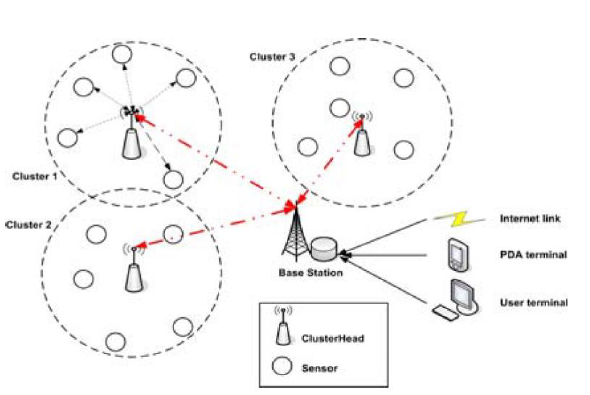
Figure 2. Wireless sensor network and nodes (Dechene et al.,